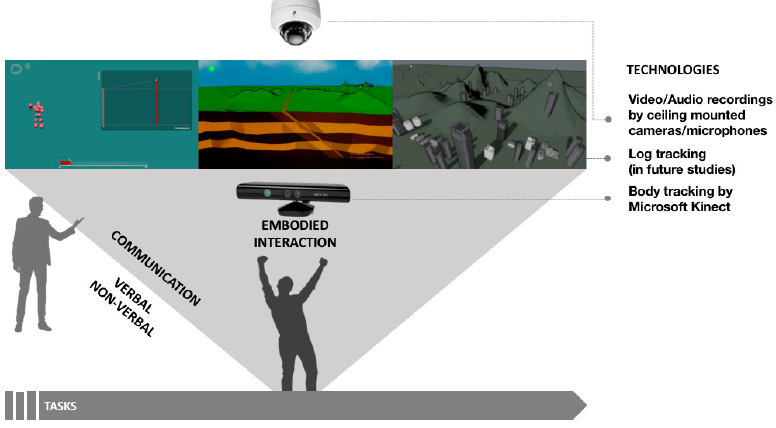
Figure 10. Multimodal learning environment and components.